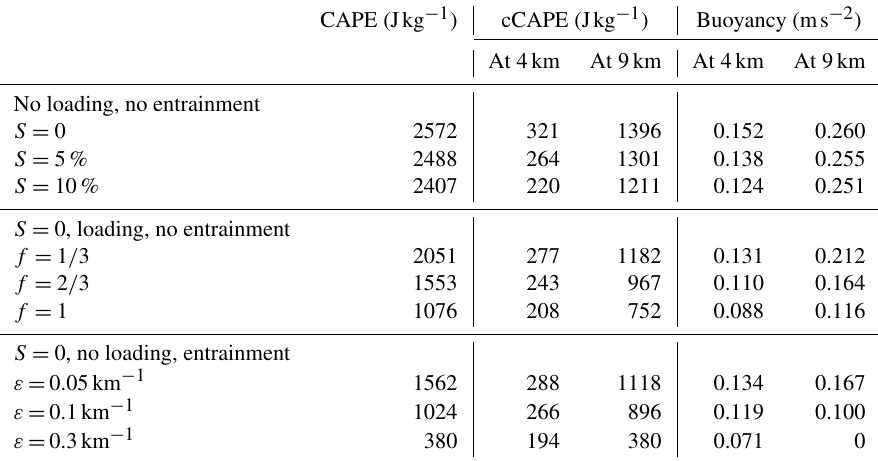
Table 2. Results from parcel simulations. The table shows CAPE together with cCAPE and buoyancy at 4 and 9km height. The first three rows show results from the pseudo-adiabatic parcel analysis assuming saturation adjustments of S = 0%, 5%, and 10% throughout the atmosphere. The middle three rows show results from parcel calculations that assume saturation adjustment and include 1 / 3, 2 / 3, and full condensate loading. The bottom three rows show results of entraining parcel calculations assuming saturation adjustment and no loading with three entrainment rates: 0.05, 0.1, and 0.3km − 1 . The initial temperature and water vapor values in the parcel are taken as averages in the lowest 500m and over hours 6 and 7 from the 2MOM PRIS ensemble. CAPE (Jkg − 1 ) cCAPE (Jkg − 1